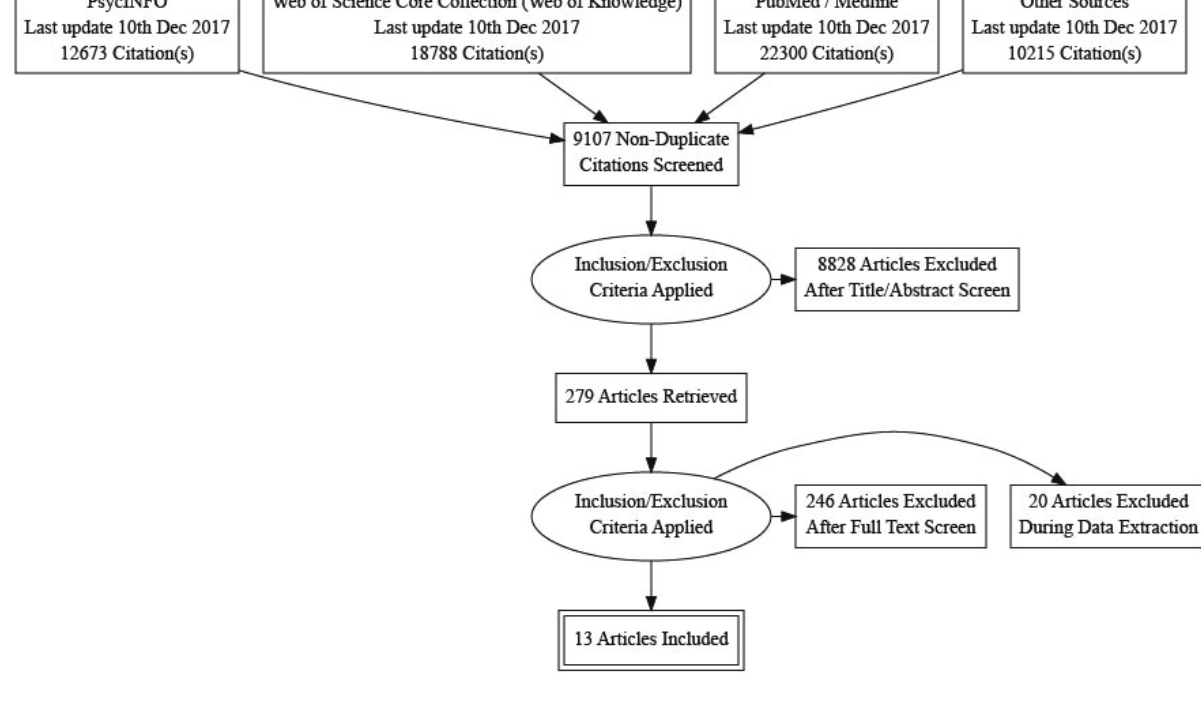
Figure 1: Flow diagram of study